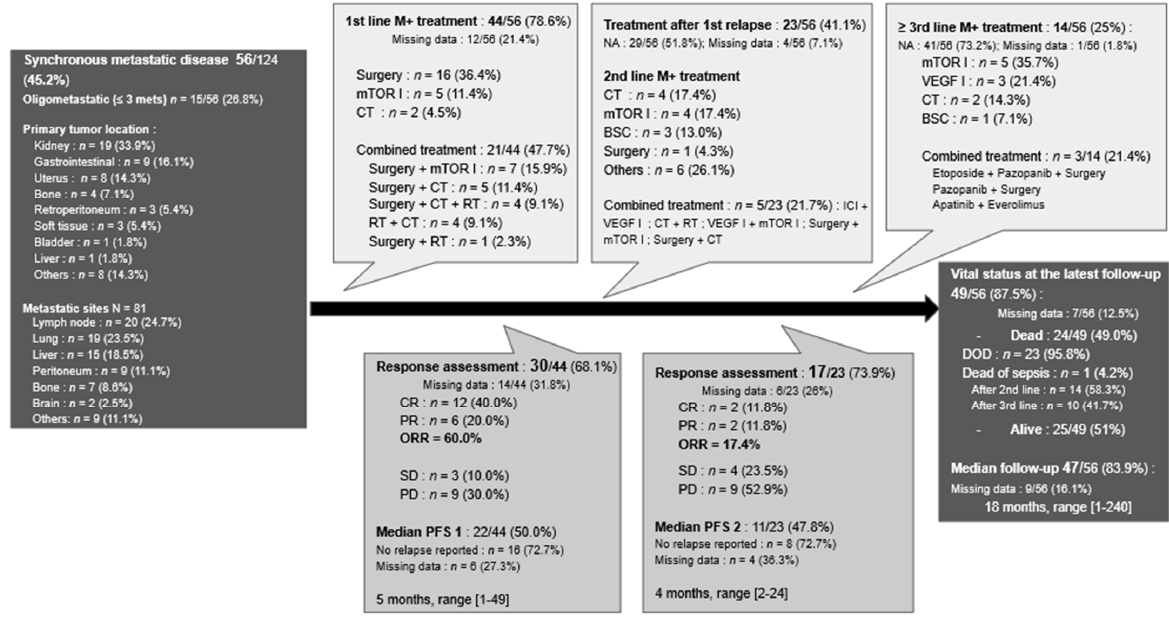
Figure 5. Flowchart of the management of synchronous metastatic PEComas. Abbreviations: BSC: best supportive care;